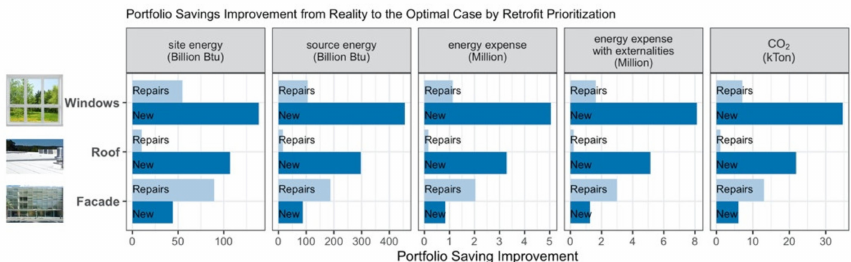
Figure 14. The benefits of prioritizing building envelope sub-actions (1 billion Btu = 1055 billion